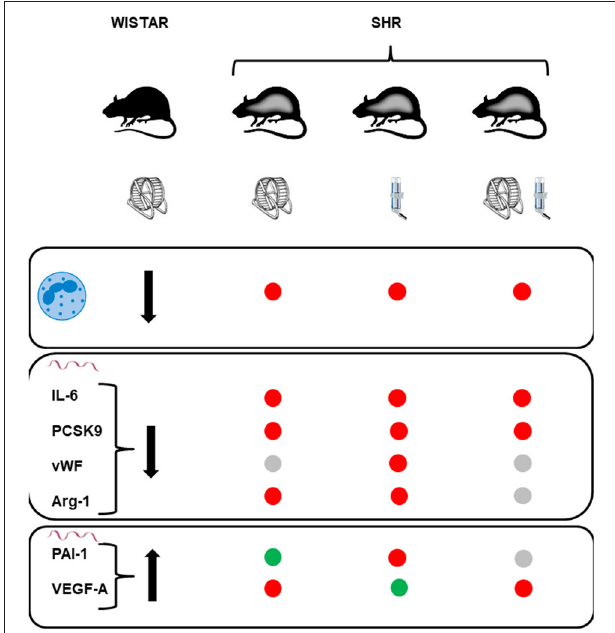
FIGURE 10 | Summary and comparison of the effects of life-long high physical activity in normotensive rats (Wistar) to those seen on these parameters in sponatenously hypertensive rats (SHR). High physical activity decreases the number of circulatin neutrophils (first raw), decreases the mRNA expression of IL-6, PCSK9, vWF, and arginase-1 (second raw), and increases the mRNA expression of PAI-1 and VEGF-A (third raw). Red points in the SHR columns stand for lack of similar effect, gray points for similar effects but of minor strength ( p > 0.05), and green points indicate similar